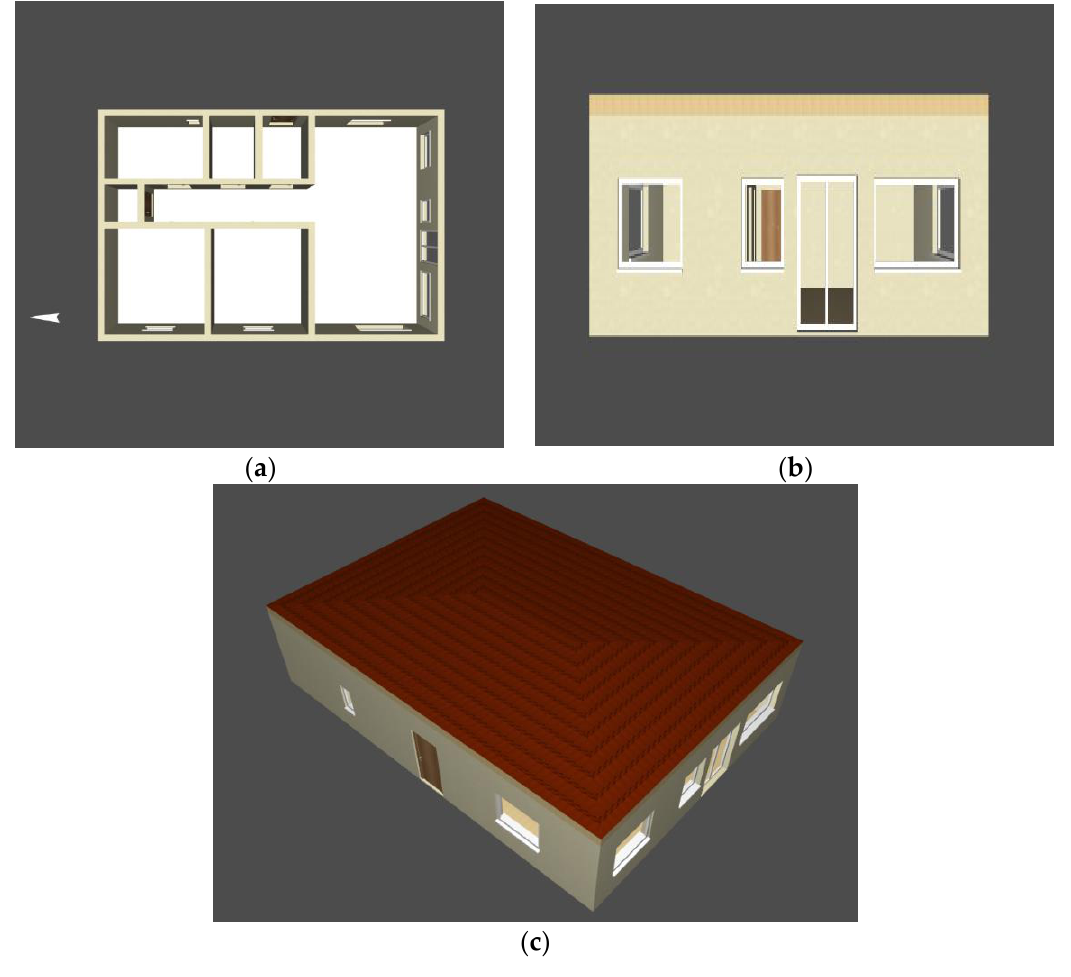
Figure 2. Analyzed building. ( a ) Building plan in 3D; ( b ) southern facade of the building; ( c ) 3D top view of the object. Source: own study.